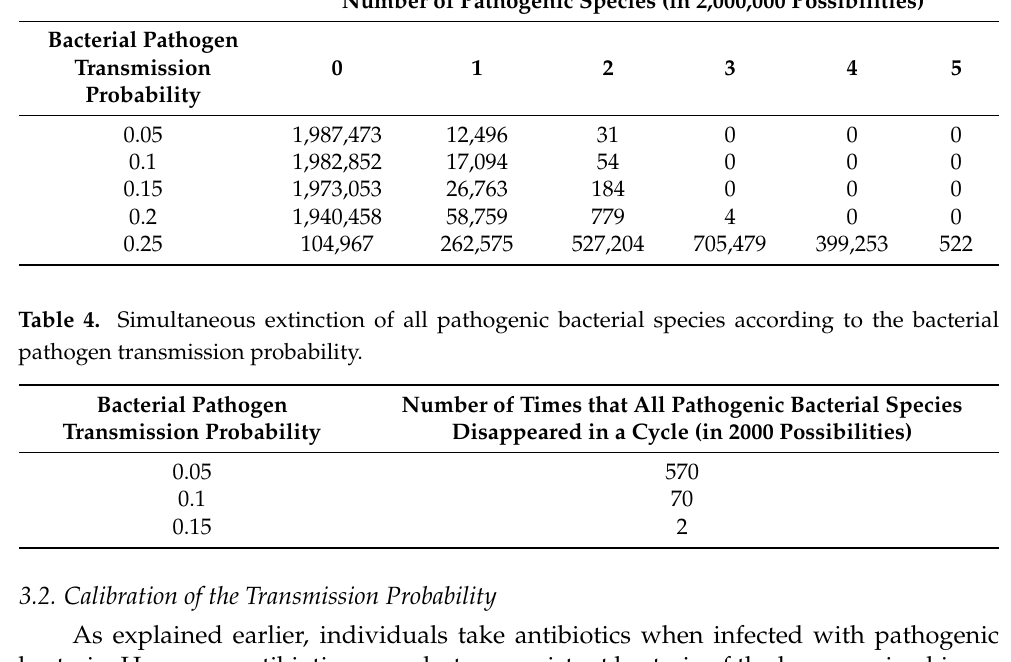
Table 3. Number of pathogenic species according to the bacterial pathogen transmission probability. Number of Pathogenic Species (in 2,000,000 Possibilities) Bacterial Pathogen